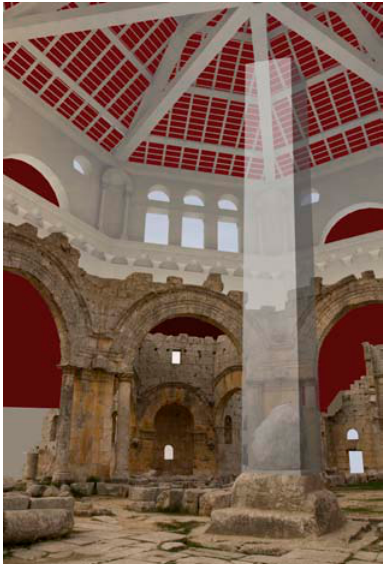
Figure 6. The drum restitution